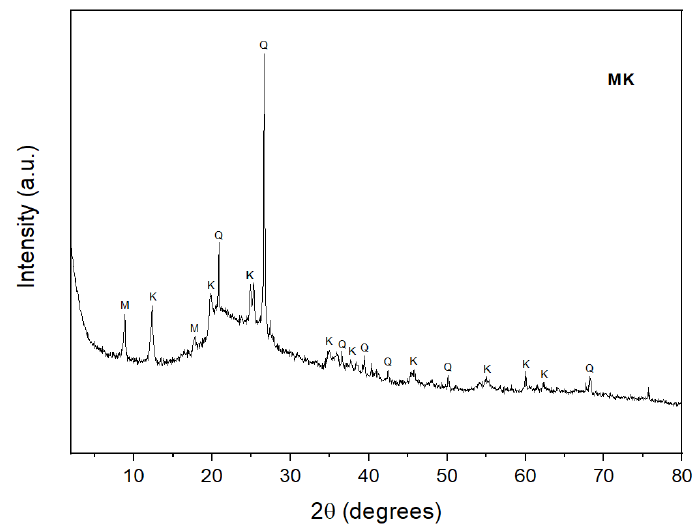
Figure 3. X-ray diffractogram of the metakaolin. M-muscovite, K-kaolinite, Q-quartz.